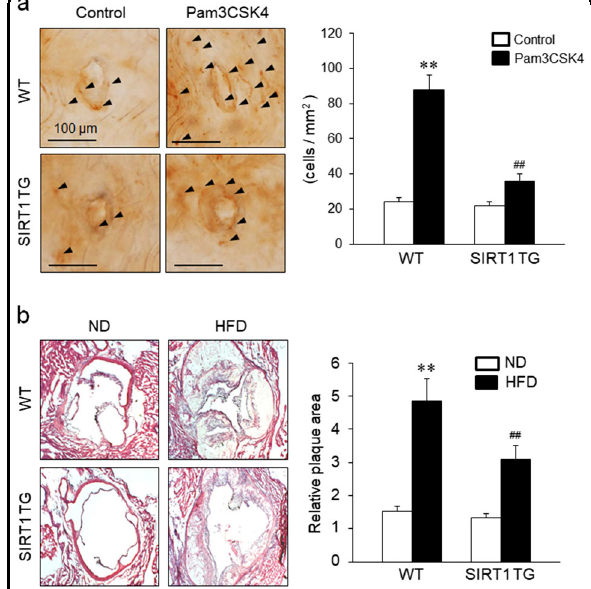
Fig. 7 The in vivo effects of SIRT1 on TLR2-mediated monocyte adhesion to the vascular endothelium and atherosclerotic plaque formation. a Representative en face views of monocytes adhering to the aortic endothelium of WT and SIRT1 TG mice treated with 1 mg/kg Pam3CSK4 for 24 h. Quantitative data shown in the right panel are presented as the means ± SEM of six independent experiments. **P < 0.01 compared with the corresponding control; ## P < 0.01 compared with the corresponding value for WT mice. Arrowheads denote Mac-1-positive cells. Scale bar = 100 μ m.